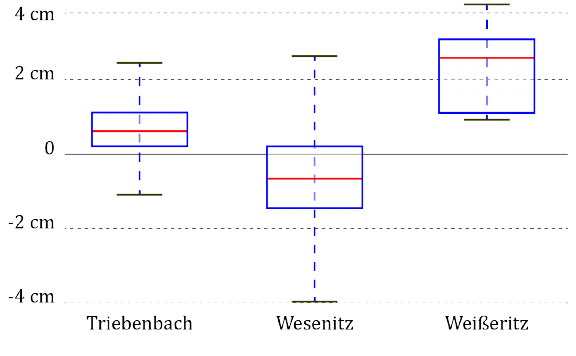
Figure 5. Deviations of water gauges (see table